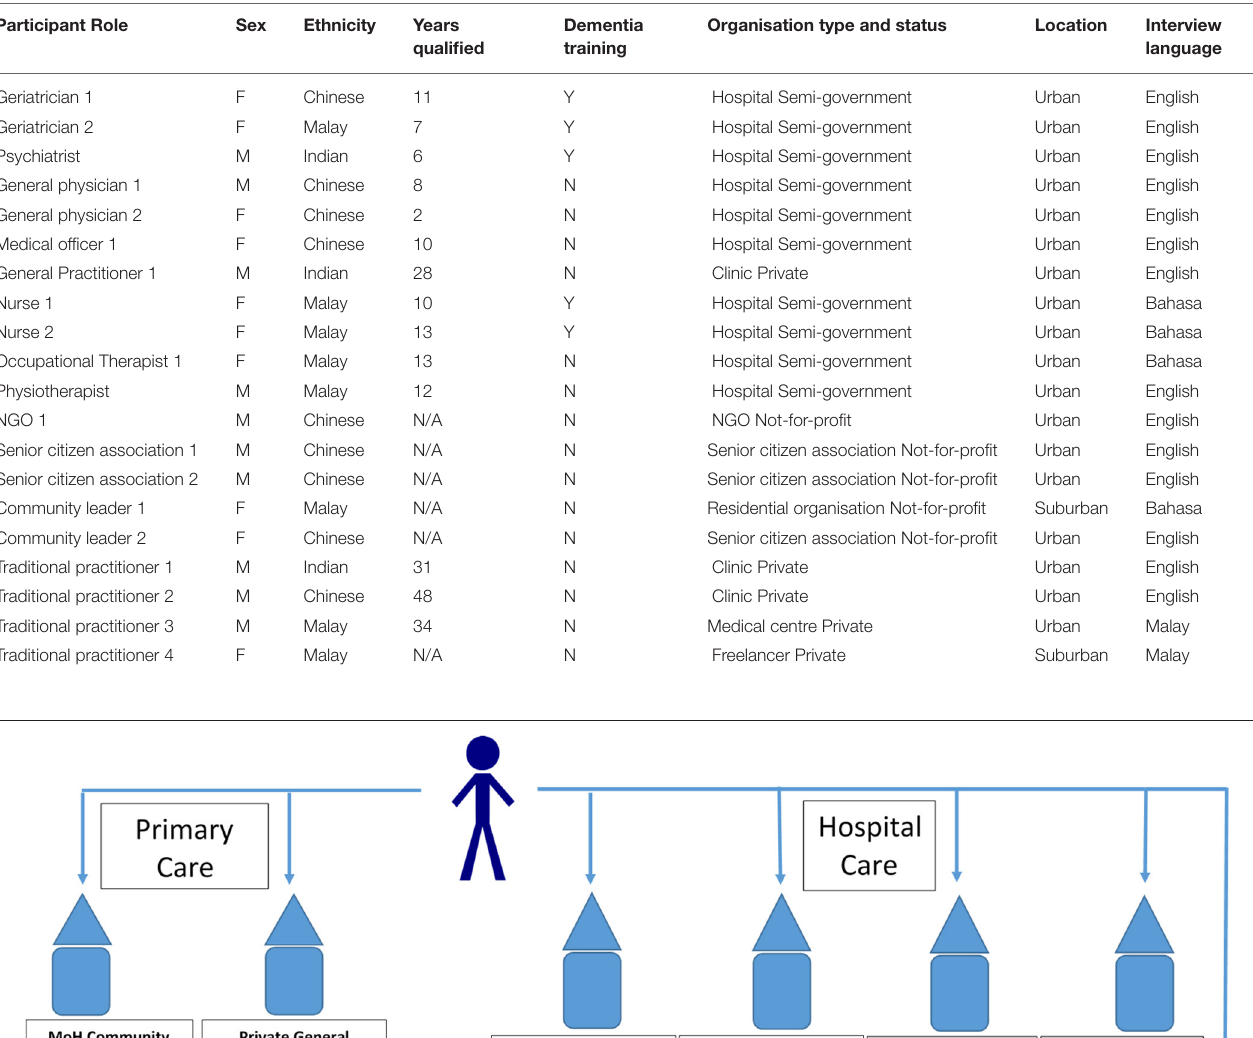
TABLE 2 | Purposive sampling frame and participant demographics.